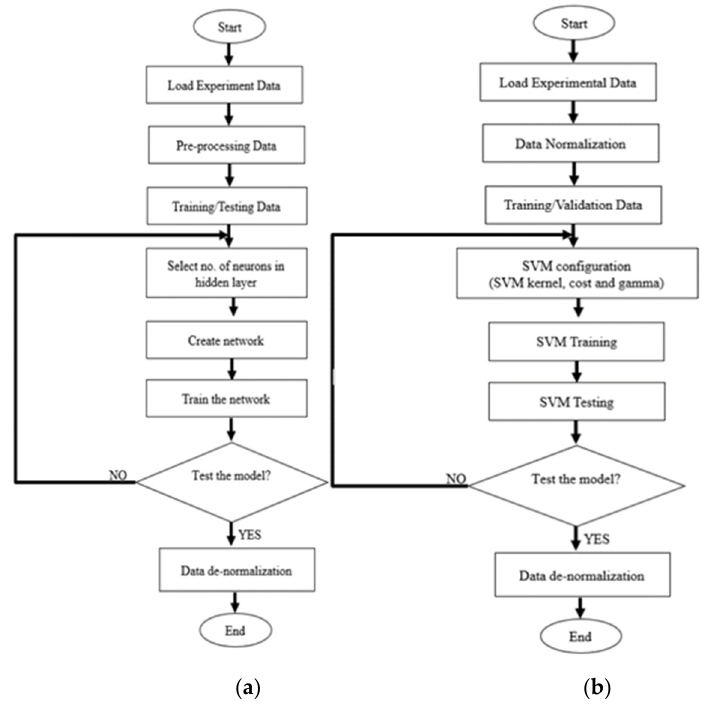
Membranes 2021 , 11 , x Figure 5 . Flow chart ( a ) ANN and ( b ) SVR prediction model. Figure 5. Flow chart ( a ) ANN and ( b ) SVR prediction model.